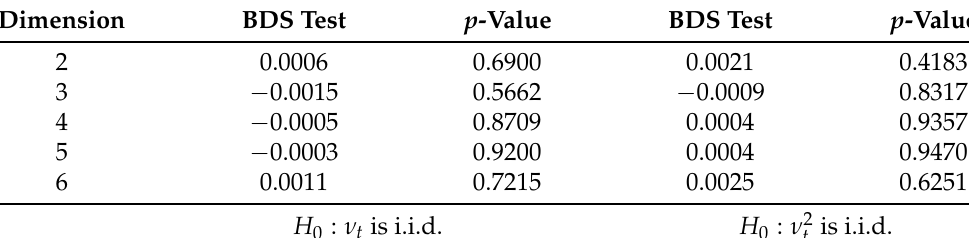
Table 3. BDS test for standardized residuals when assuming